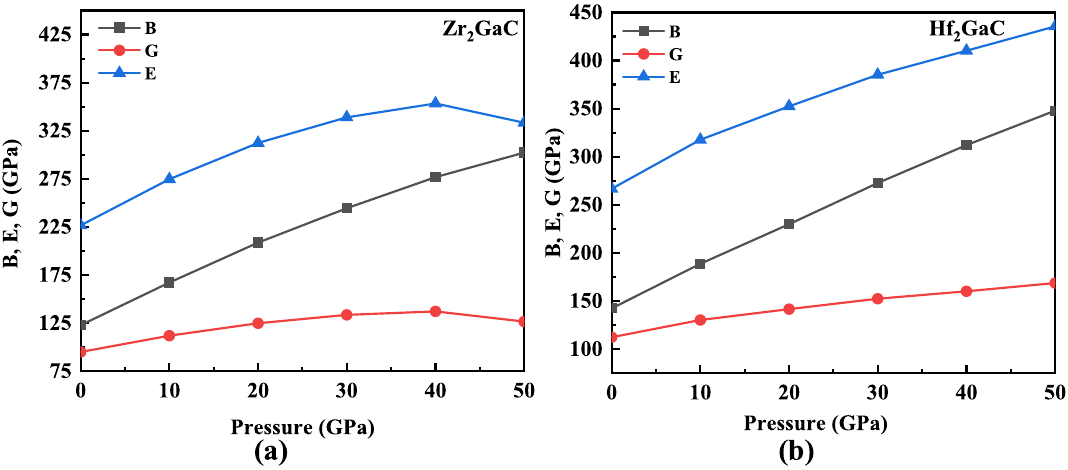
Figure 10. Variation of elastic moduli of M 2 GaC MAX phase (M = Zr, Hf) with pressure.